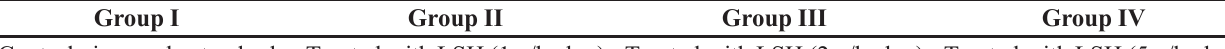
TABLE I - Group scheme for acute oral toxicity study of LSH in mice Group